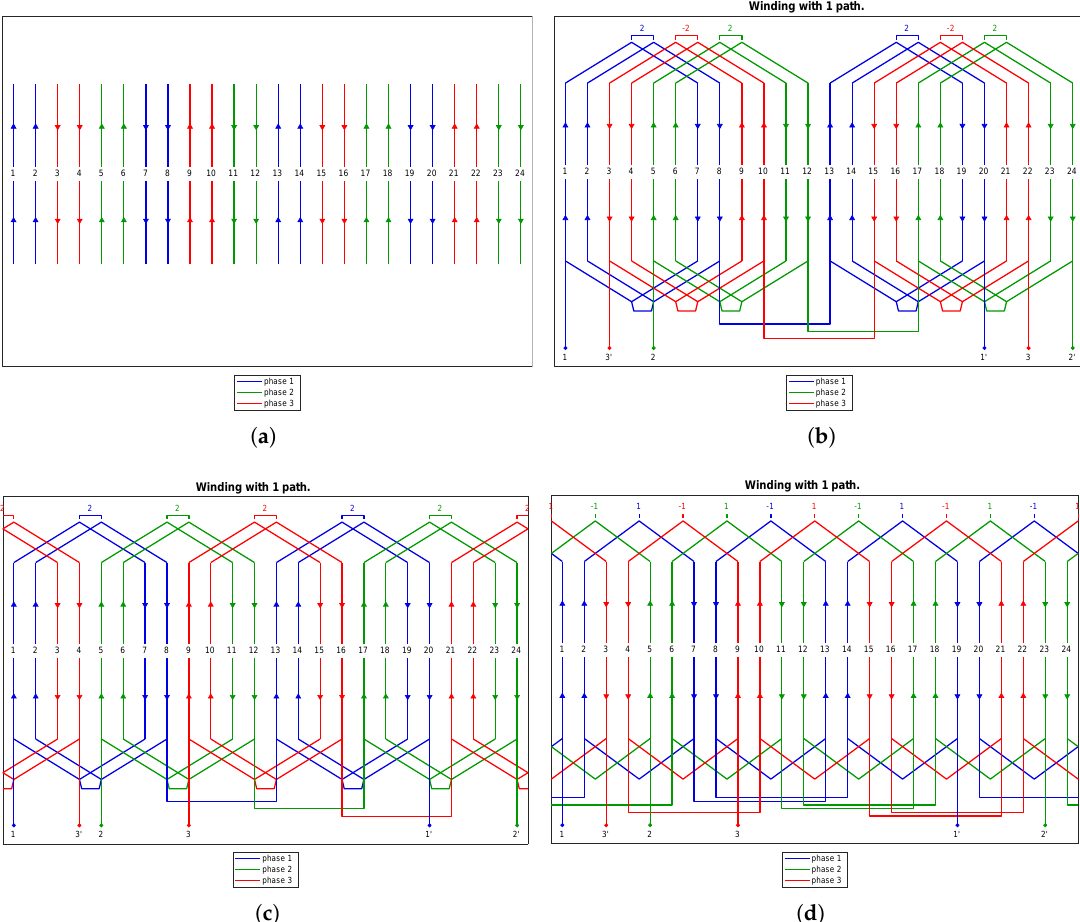
Figure 2. Winding schemes with different end winding layouts for a single-layer configuration with N = 24, m = 3, p = 2 and q = 2 derived from the WDT. ( a ) Without end connections; ( b ) for a split stator and three-plane end winding; ( c ) with two-plane end winding and ( d ) with three-plane end